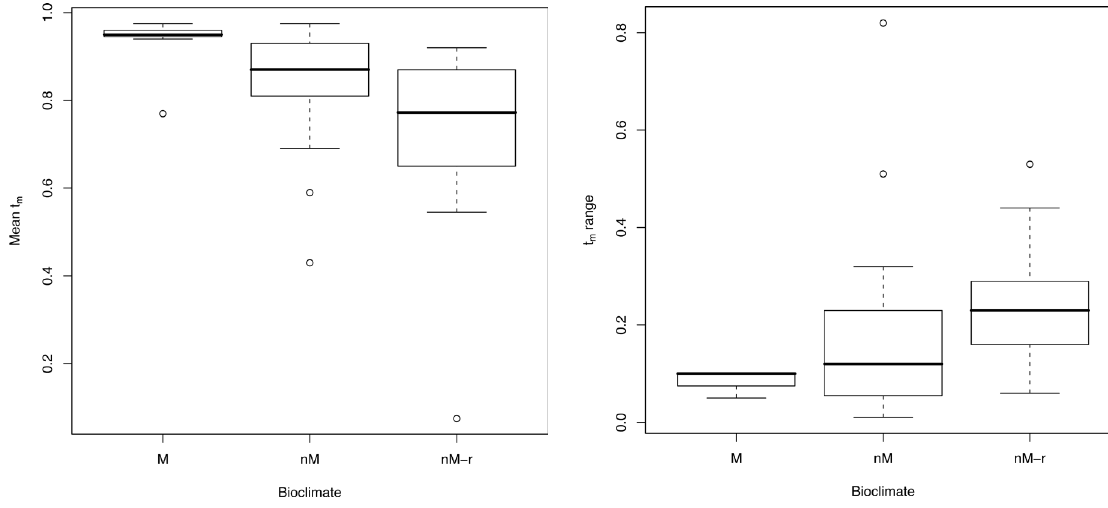
Fig. 2. Outcrossing rates over three bioclimates (Mediterranean, M, non-Mediterranean, nM, and rear edge non-Mediterranean nM-r) in Abies , Picea and Pinus species worldwide.